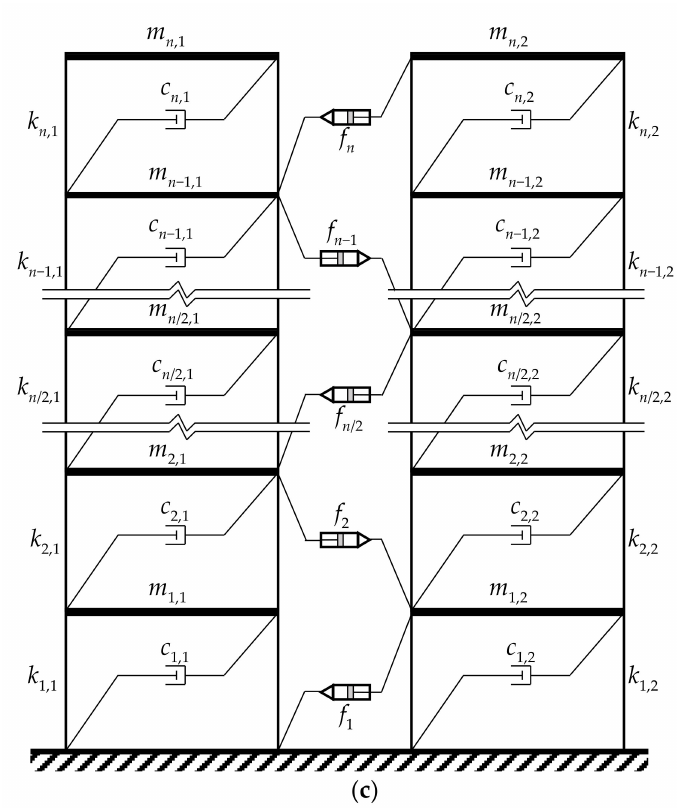
Figure 7. Adjacent dynamically similar buildings connected by MR dampers in: ( a ) Configuration 2: MR dampers are used in the top half portion only; ( b ) Configuration 3: MR dampers are used in the bottom half portion only; and ( c ) Configuration 4: MR dampers are connected at alternate